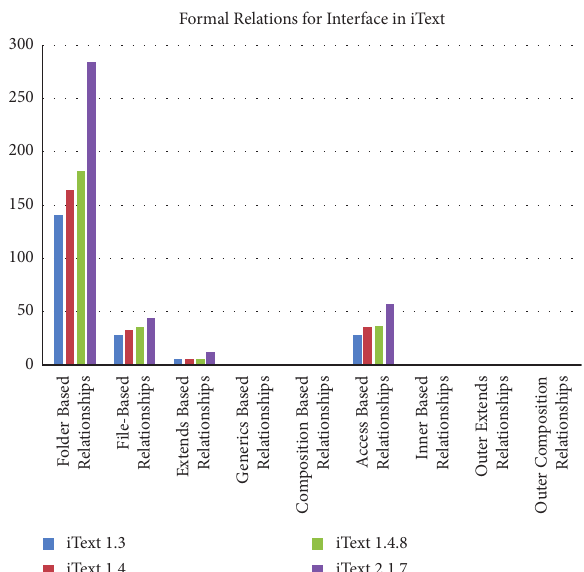
Figure 7: Count of formal relationships for interface in